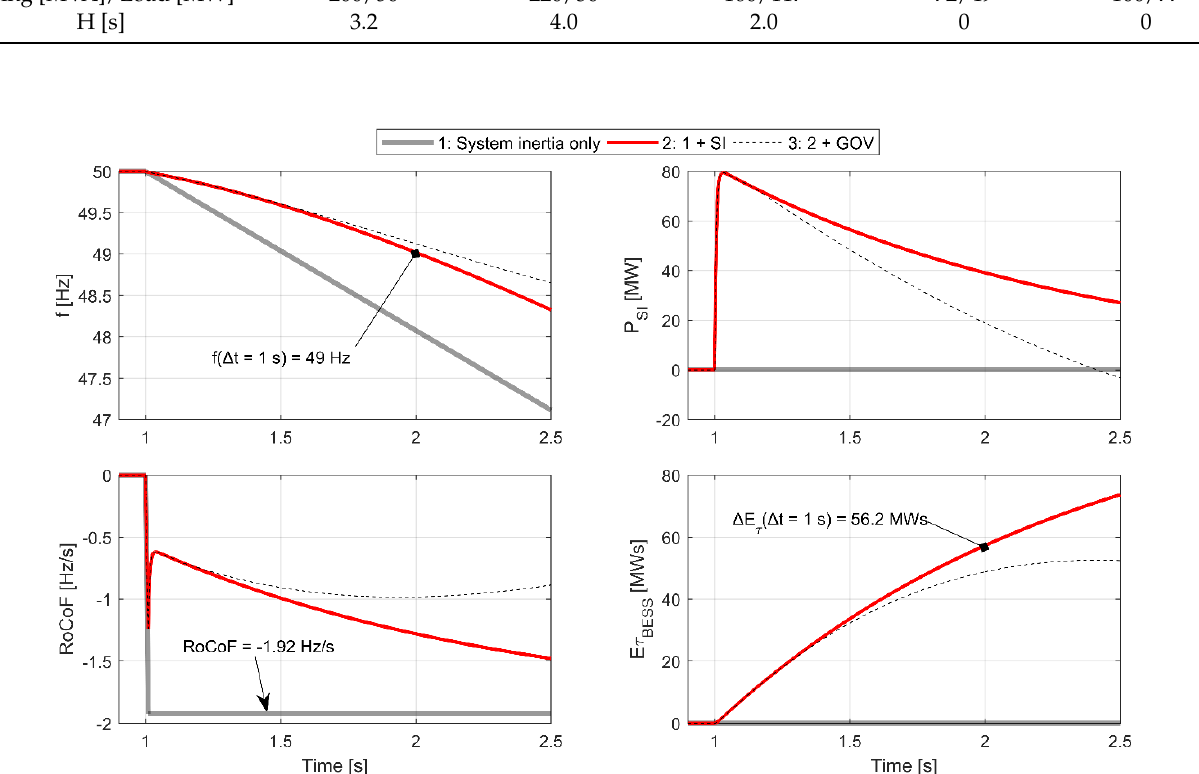
Figure 5. Response to generation trip of 1. purely inertial system (grey line); 2. inertial system with synthetic inertia (SI support exhibiting linear decline of frequency in the first 0.5 s (red line); 3. same as no. 2 but with governor action (dashed line).